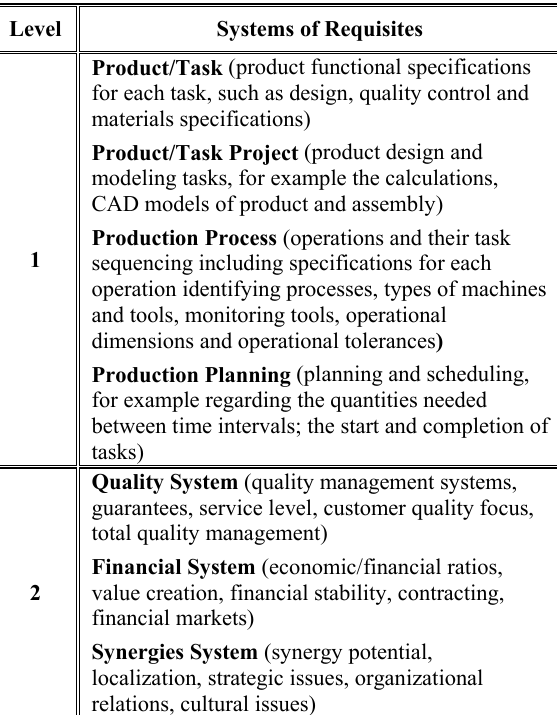
Table 1. Levels and systems of requisites for the pre- selection.